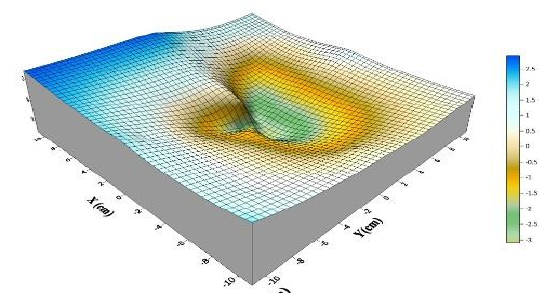
Fig. 7(m): The Scour and Deposition Pattern around Pier (P 1 ) at angle 19 0 and flowrate 9 L/Sec.